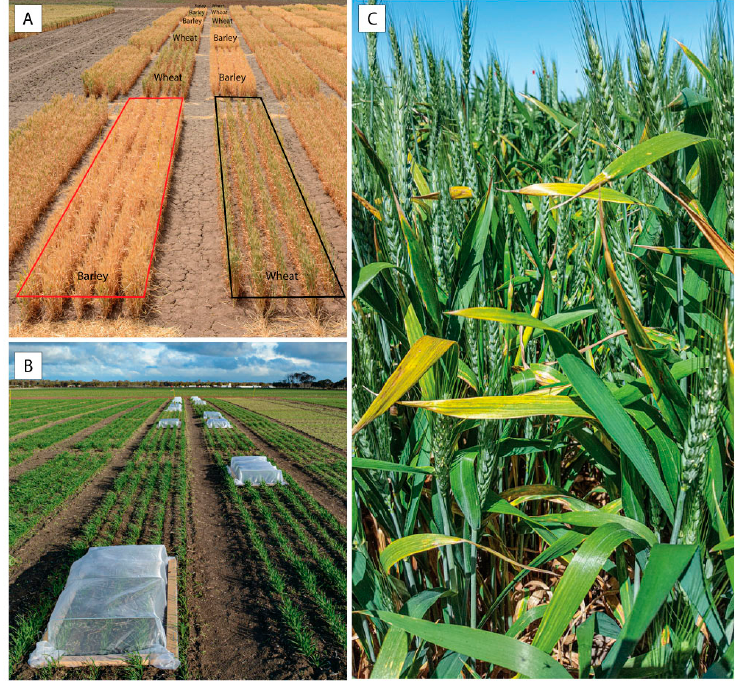
Figure 1. ( A ) The experimental layout in wheat and barley; ( B ) Field inoculation cages used to cover the virus-treated plots during inoculation; ( C ) Widespread leaf-yellowing symptoms of barley yellow dwarf virus (BYDV) background infection observed in non-inoculated control plots of wheat in 2017 in South-Eastern Australia.